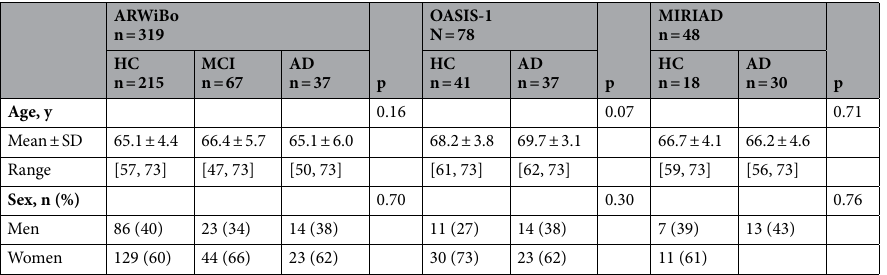
Table 2. Demographic information for the subjects from the Alzheimer’s Disease Repository Without Borders (ARWiBo) dataset, the Open Access Series of Imaging Studies: Cross-Sectional (OASIS-1) dataset, and the Minimal Interval Resonance Imaging in Alzheimer’s Disease (MIRIAD) dataset. We used ANOVA test and the chi ‐ square test of homogeneity to test for significant differences in age and sex between healthy controls and patients. Abbreviations: HC = healthy control; AD = Alzheimer’s disease; MCI = mild cognitive impairment; SD = standard deviation.